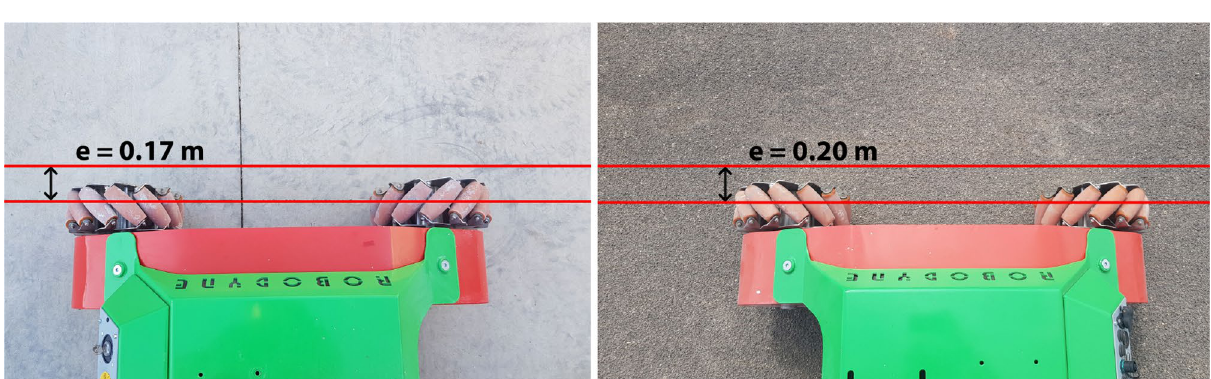
Figure 18. Final maximum error obtained on concrete, on the left, and on asphalt, on the